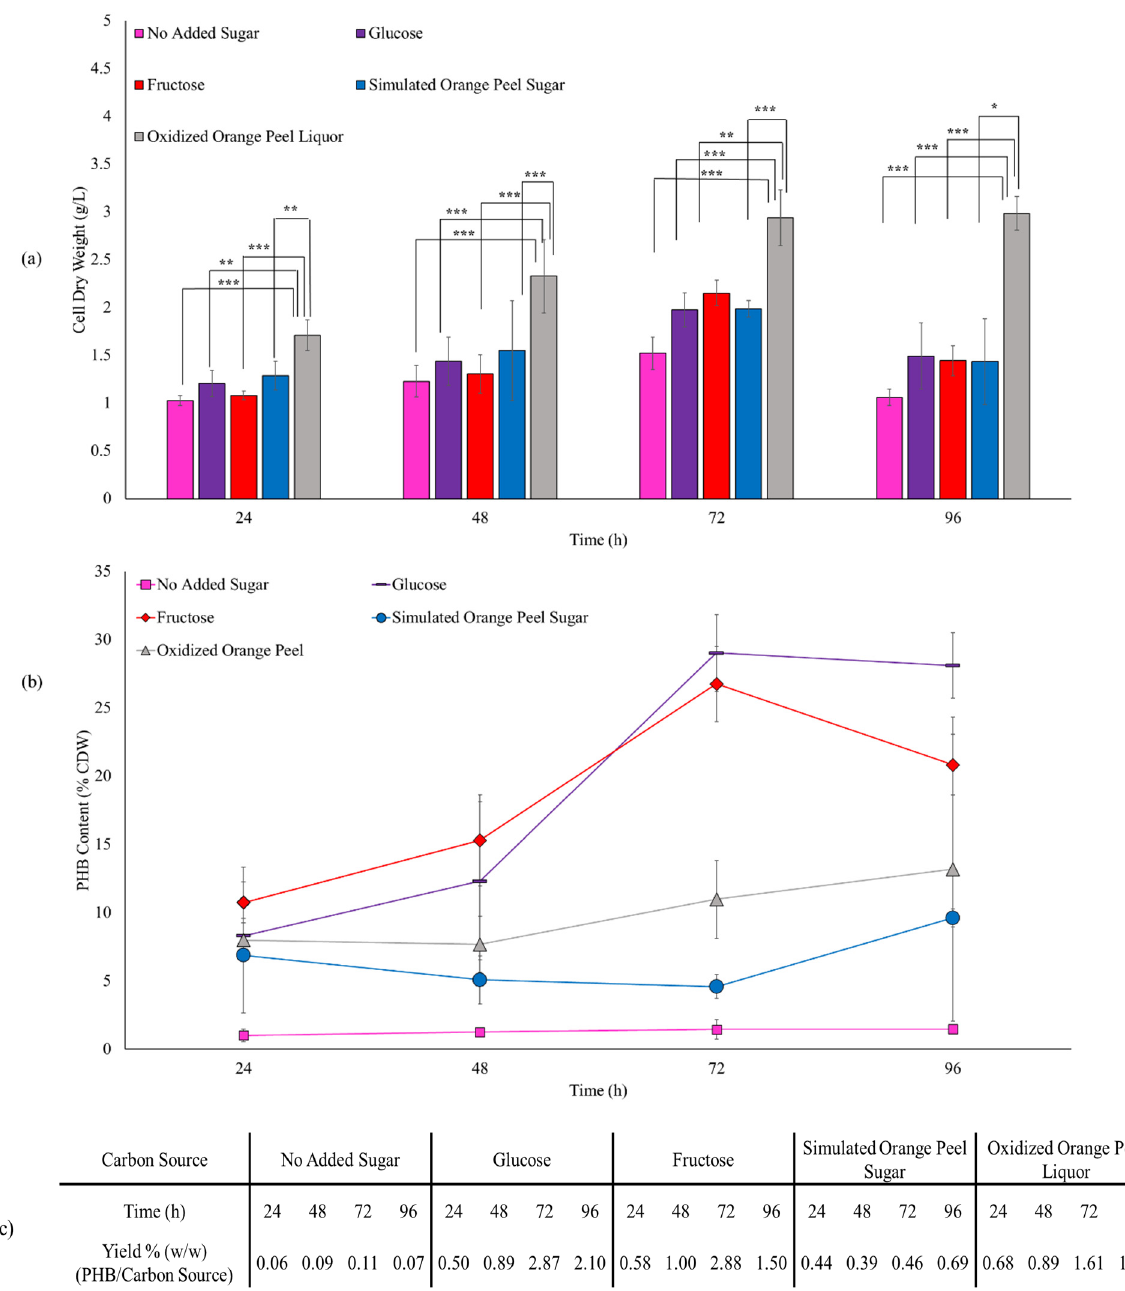
Figure 8. ( a ) Effect of various carbon sources on JM109 cell dry weight (bars) and ( b ) PHB content (lines). Error bars represent the standard deviation of uncertainty with 95% confidence interval. Statistical significance of data (* p < 0.05, ** p < 0.01, *** p < 0.001). ( c ) Production yields of PHB/sub-